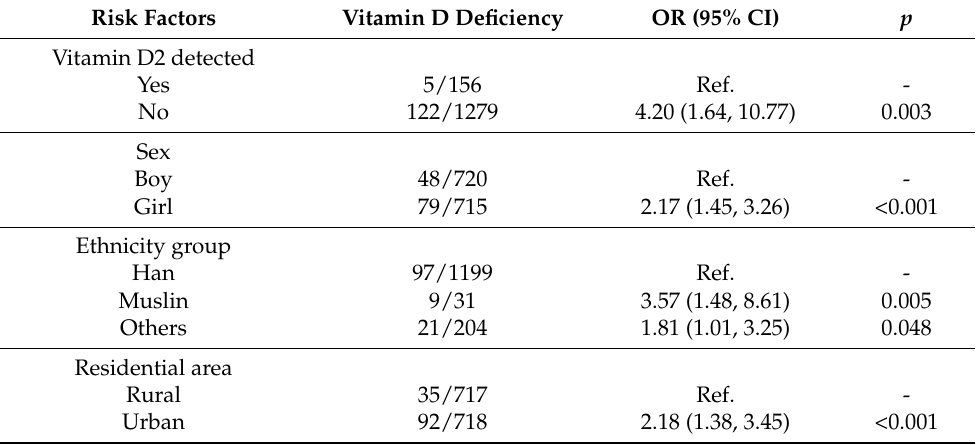
Table 3. Relationship between vitamin D2 detected and vitamin D deficiency of children aged 3–5 years in